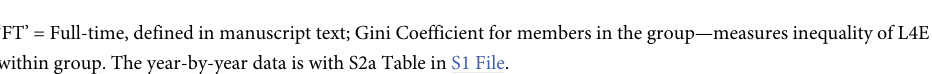
‘FT’ = Full-time, defined in manuscript text; Gini Coefficient for members in the group—measures inequality of L4E within group. The year-by-year data is with S2a Table in S1